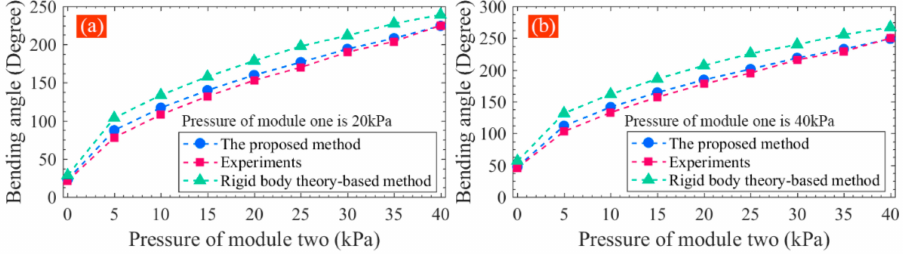
Figure 13. Comparison between the traditional and the proposed method for bending angle calcula- tion: ( a ) pressure applied to pneumatic module one maintains at 20 kPa and ( b ) pressure applied to module one maintains at 40 kPa.